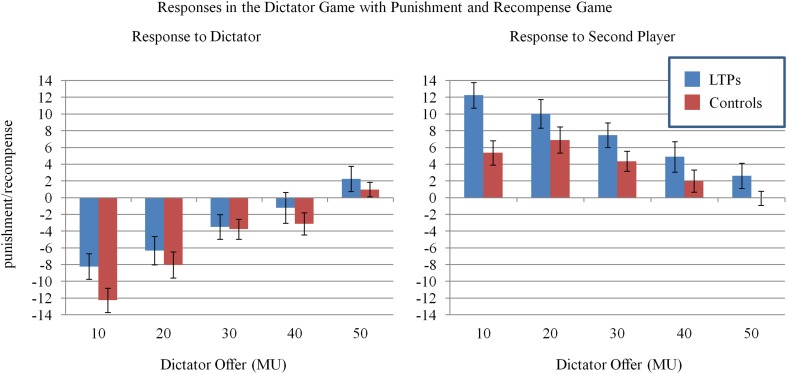
Plots depicting pooled means and standard errors of responses in the dictator game with third-party punishment and recompense (3PR). Punishment is represented as a negative number where one MU spent to punish is −1 MU. Recompense is represented as a positive number where one MU spent to recompense is +1 MU. The mixed models of these data revealed that as dictator offers decreased, participants punished the dictators and recompensed the second players more (ps < 0.001). LTPs' punishment behavior did not differ from controls, but they were more likely to recompense (ponetailed = 0.03). Moreover, LTPs' recompensatory behavior was more strongly coupled with Dictator Offers (p = 0.05).